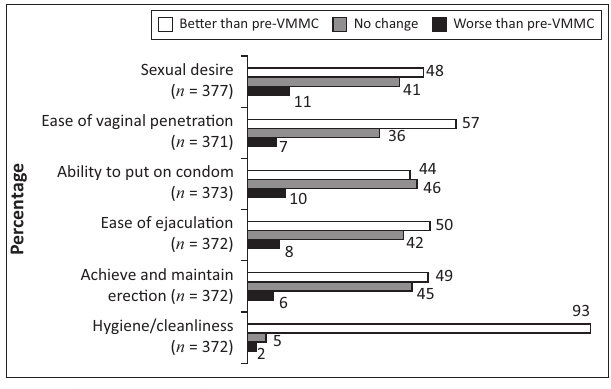
FIGURE 1: Study flowchart for men who underwent voluntary medical male circumcision and were enrolled in the parent study between November 2013 and October